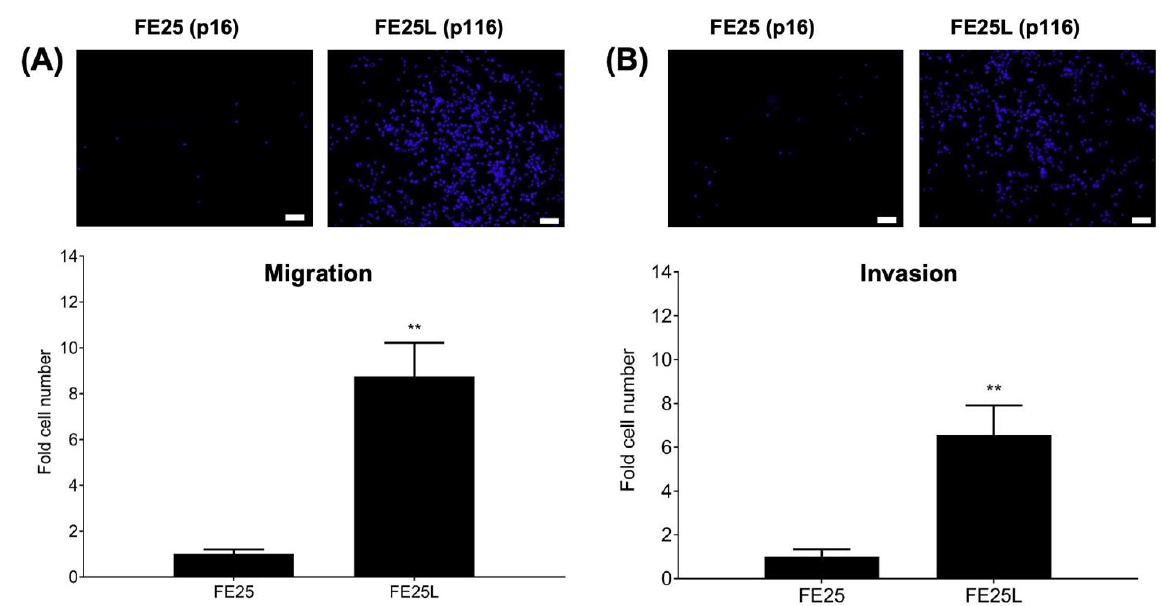
Figure 2. Migration and invasion assay in FE25 (p16) and FE25L (p116) cell lines. ( A ) Trans-well migration assay. Culture medium 500 µ L was added to lower chamber. After cells migrated for 48 h, cells on the membranes were stained with DAPI. Blue immunofluorescence-stained migrated cells were pictured by a microscope (upper panel). Then migrated cells were quantified and compared between the two cell lines (total migrated cells on the membranes) ( n = 3 in each group). ( B ) Trans-well invasion assay. Upper chamber was coated with Matrigel. The other steps of the experiment were the same as described above ( n = 3 in each group). ** p < 0 .01. Scale bar = 100 μm. The upper panel shows a representative image of the experiment.